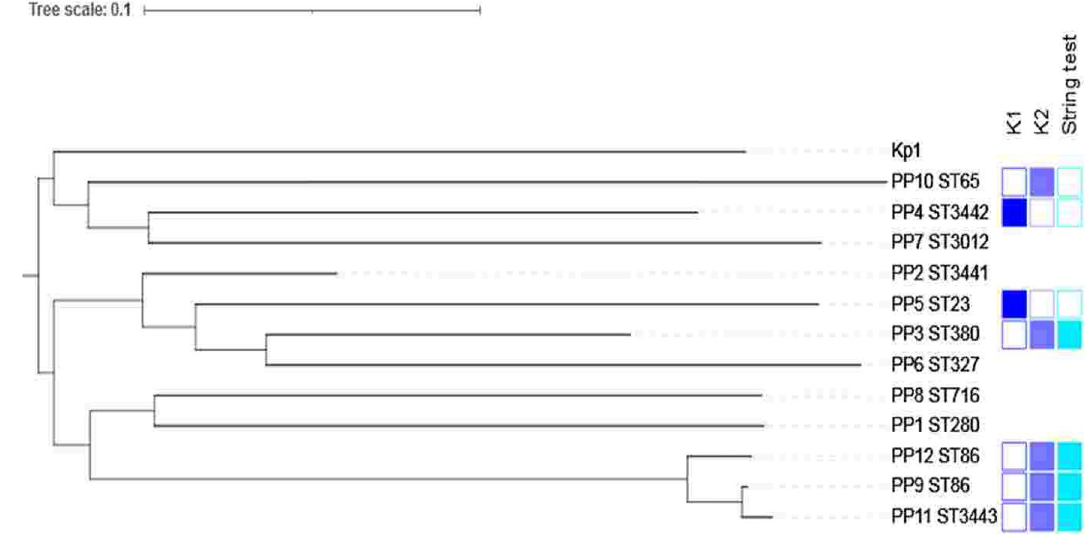
Figure 2. Phylogenetic tree of K. pneumoniae isolates obtained from 12 patients. The tree includes the sequence types (ST) of each isolates, the frequency of K-types in indigo and the string test positive in blue